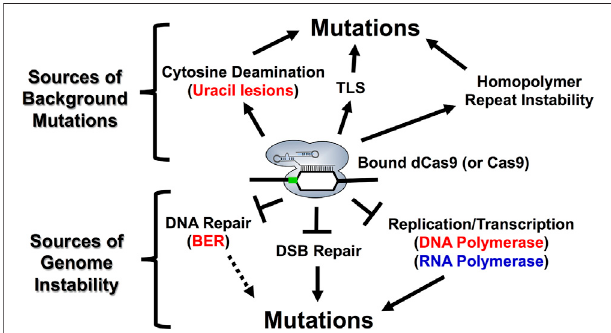
FIGURE 6 | Model describing the molecular mechanisms associated withCas9 mutagenesisinS.cerevisiae. R-loopformationand DNAbindingby Cas9 endonuclease can inhibit endogenous cellular processes such as BER, NHEJ, DNA replication and RNA transcription resulting in distinct on- and off-target mutational pro fi les for both active Cas9 and the dCas9/nCas9 enzymes that are used in either base editing or transcriptional regulation applications. Each of the factors in fl uencing mutagenesis at the top of fi gure can be generated upon R-loop formation by dCas9. Base substitutions ( ex. C to T or C to G) can be explained by cytosine deamination and the subsequent activity of BER or TLS enzymes. Complex mutations such as indels and structural variations can be explained, in part, by targeting homopolymer sequences with dCas9 as well as replication stress from bound dCas9 (bottom of fi gure). Additionally, inhibition of other cellular processes, such as BER,NHEJ,andRNApolymerasesarelikelytoimpact bothon-andoff-target mutational outcomes with Cas9 proteins. For example, the extent to which inhibition of RNA polymerase by Cas9 binding impacts mutagenesis is likely re fl ected in how readily RNA polymerase can dislodge bound Cas9 from a genomic target site. Notably, RNA polymerase is more likely to dislodge bound Cas9 when it is targeted to the transcribed strand. This likely impacts Cas9 activity in cells by allowing Cas9 to better function as a multi-turnover enzyme in vivo . The PAM motif is indicated by the green box. For more details see Gilbert et al., 2013; Clarke et al., 2018; Laughery et al., 2019; Doi et al., 2021; Antony et al.,